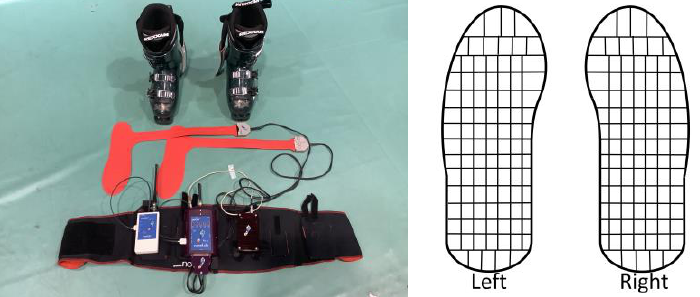
Figure 3. Plantar pressure distribution sensor set in each ski boot ( left pane ). The participants were able to ski without any restriction of movement. Each plantar was divided into 99 areas to measure the plantar pressure distribution ( right pane ).